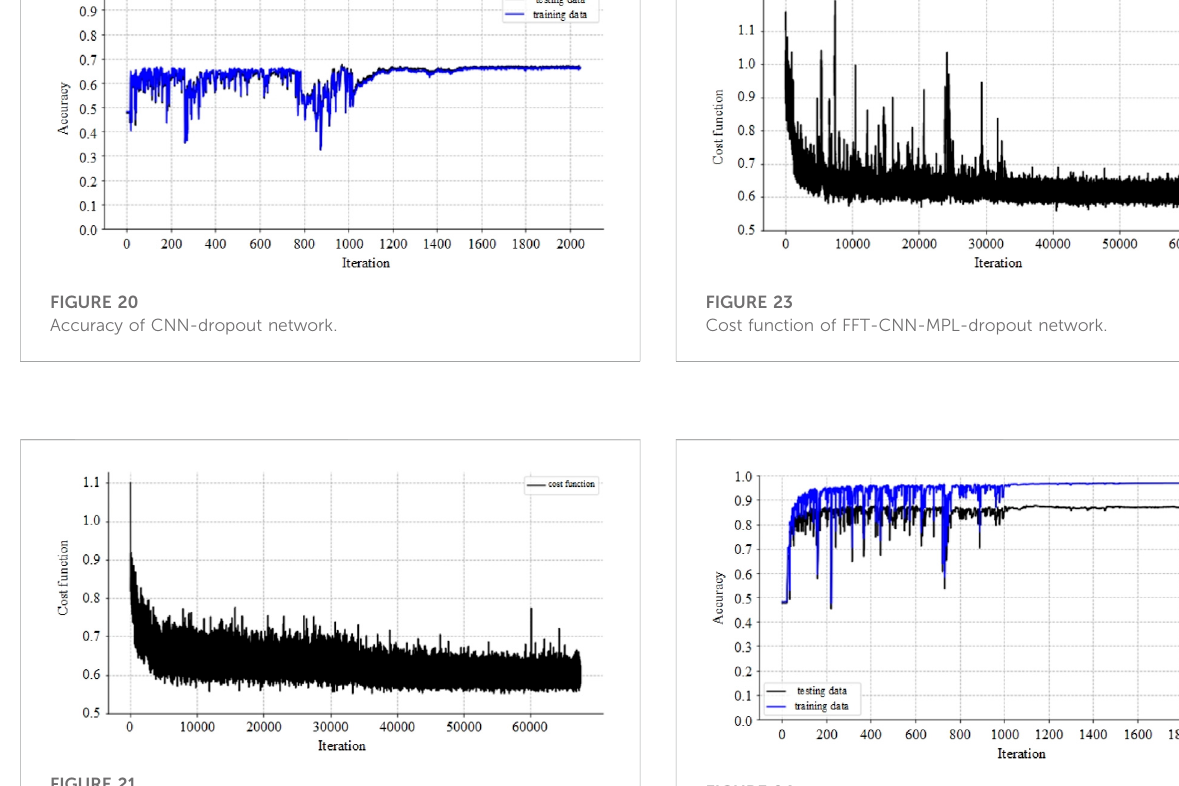
FIGURE 24 Accuracy of FFT-CNN-MPL-dropout